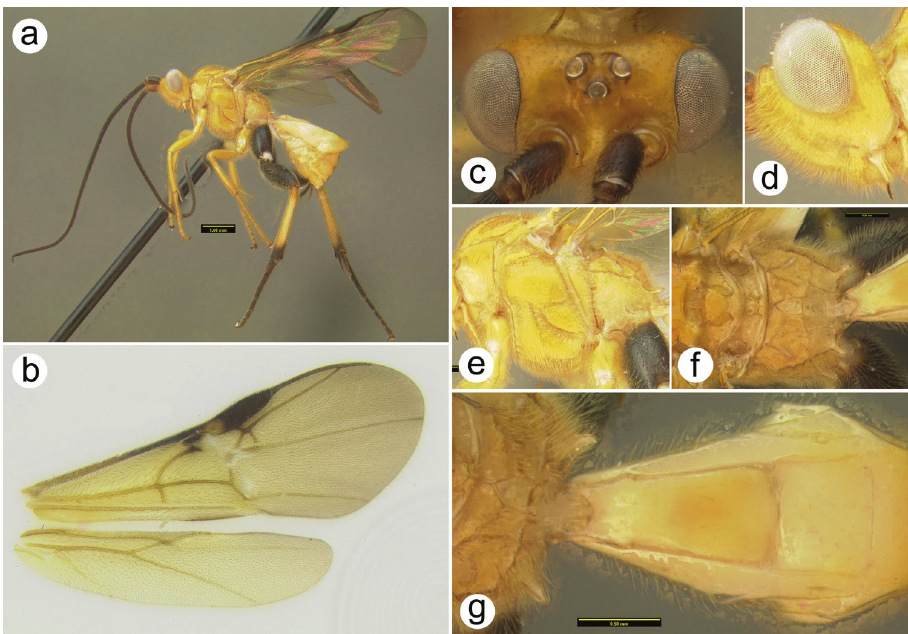
Figure 22. Zelodia wirati sp.n. a lateral habitus b wings c dorsal head d lateral head e lateral mesosoma f dorsal propodeum g dorsal